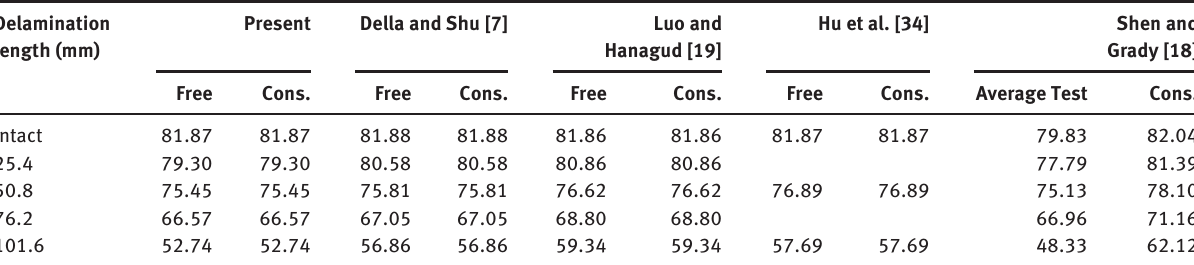
Table 3 Fundamental frequencies (Hz) of the LCB with central delamination located at interface 2.